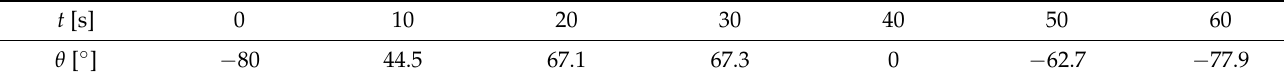
Table 3. Variation in time of the wrist rotation angle.